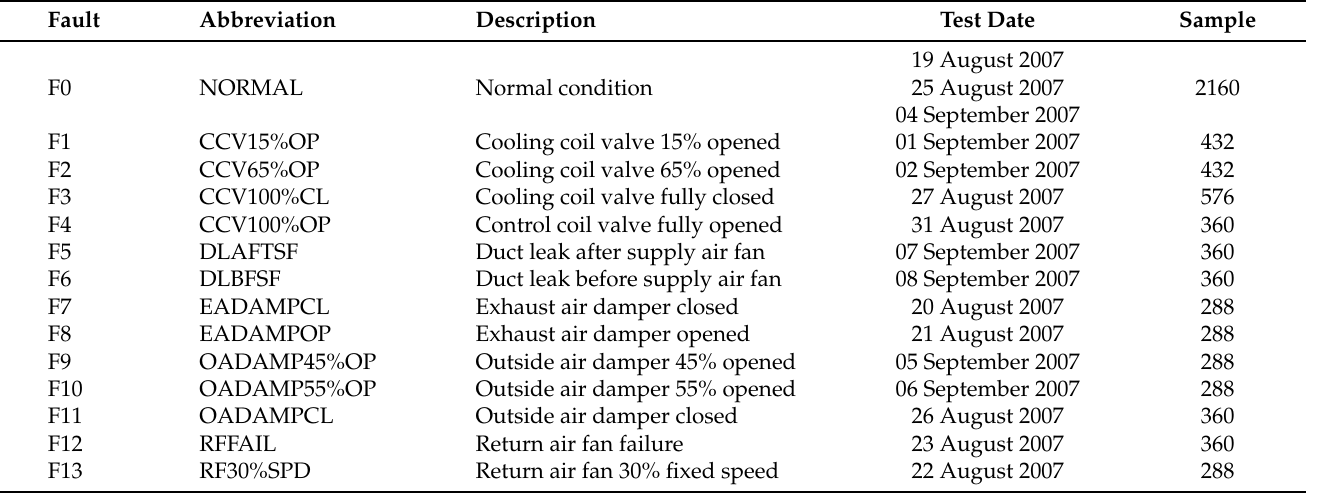
Table 1. Summary of AHU faults considered in the proposed FDD